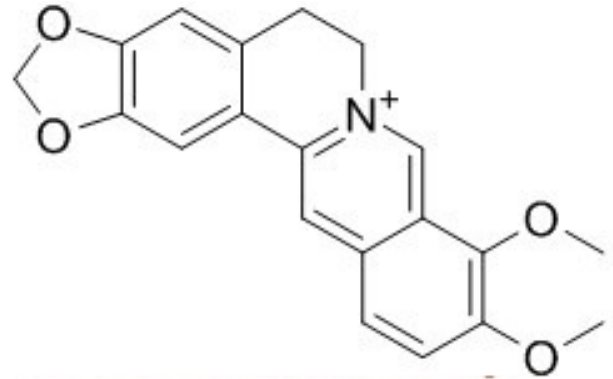
Figure 3. Chemical structure of Berberine.